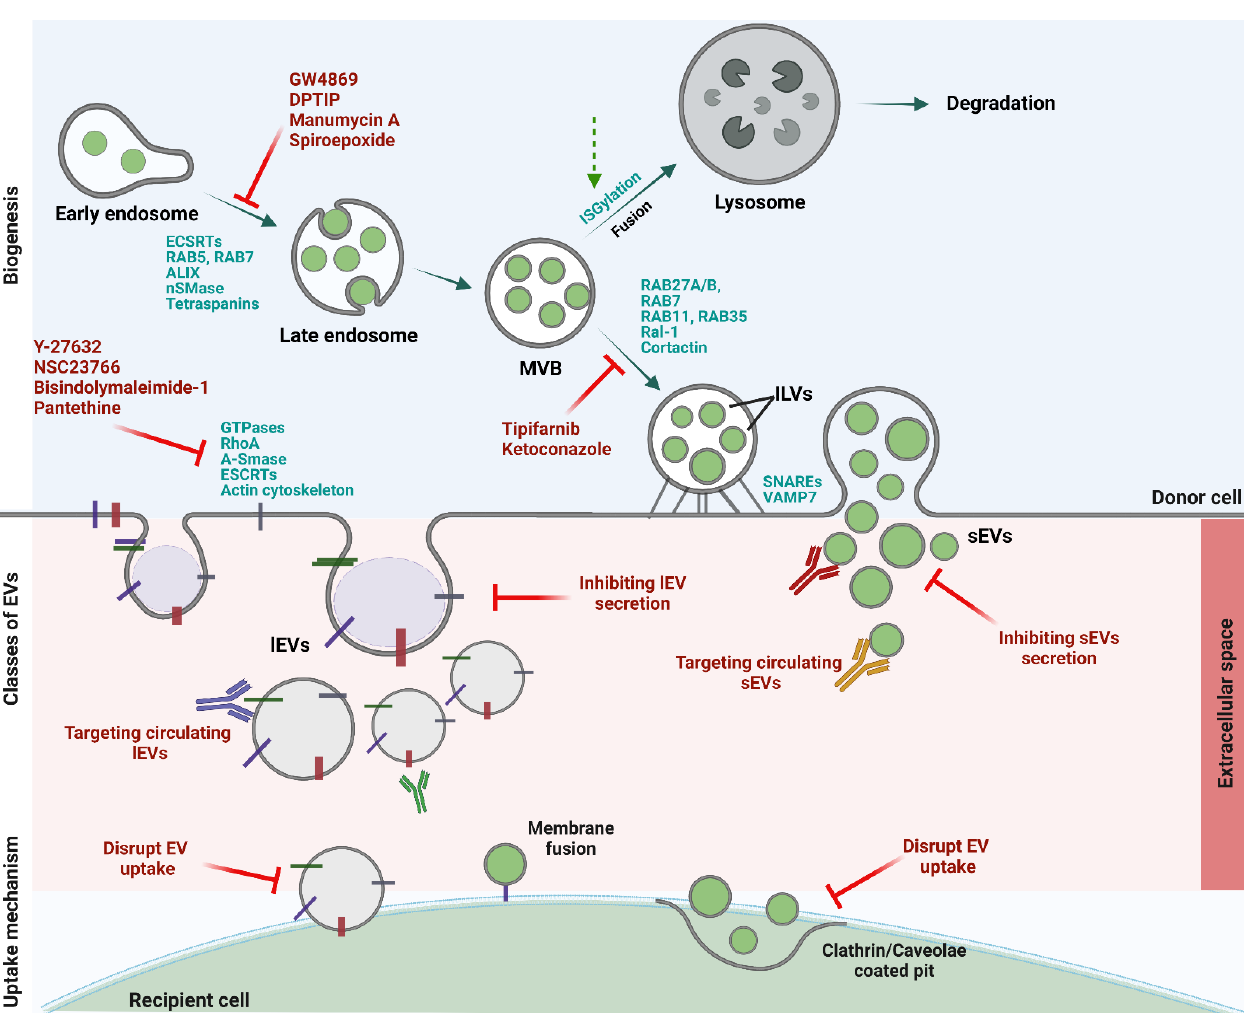
Figure 2. Therapeutic targets and agents against cancer-derived EVs. Various classes of EVs are generated through different biogenesis pathways and involve several proteins. These proteins can be therapeutically targeted to inhibit their biogenesis, secretion, and uptake by the recipient cells. Red lines: pharmacological agents affecting biogenesis, secretion, and uptake of EVs. Green dotted line: activator/s of ISGylation that promote fusion of MVBs with lysosomes for